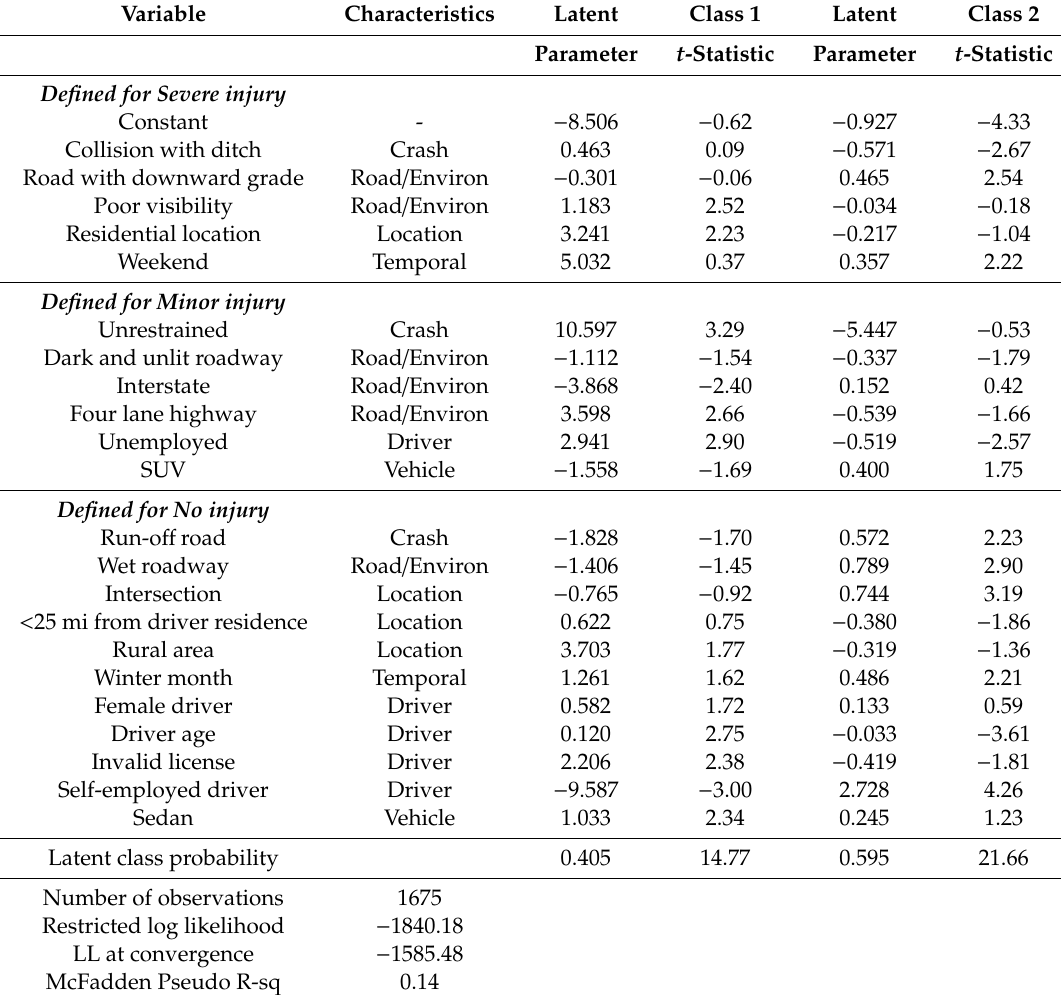
Table 3. Latent class logit model estimation results for multi-occupant DUI